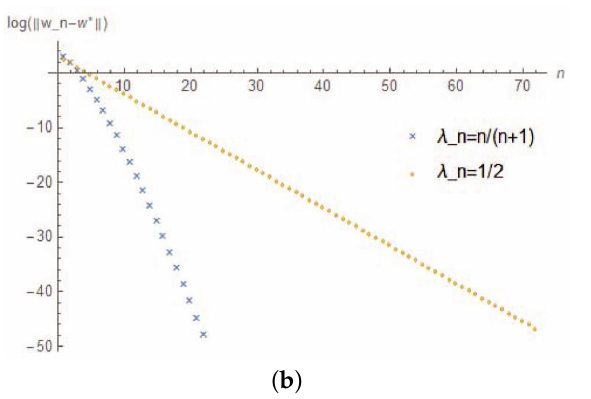
Figure 1. Numerical